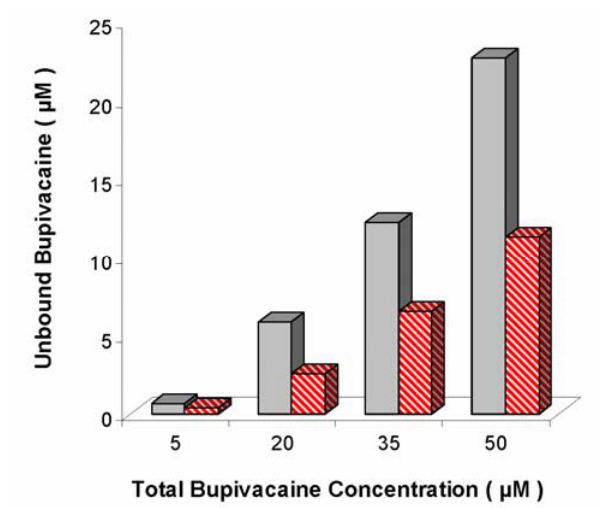
Figure 6. Free bupivacaine (unbound to proteins and/or liposomes) versus total bupivacaine concentration in human serum samples in the absence ( ) and presence ( ) of unilamellar, 95:5 DOPG:DPPE-mPEG-2000 liposomes at 2.9 mg lipid/mL. Differences were significant at all concentrations tested (P = 0.037, 0.022, 0.042 and 0.018 for 5, 20, 35, and 50 µM, respectively). Figure adapted from